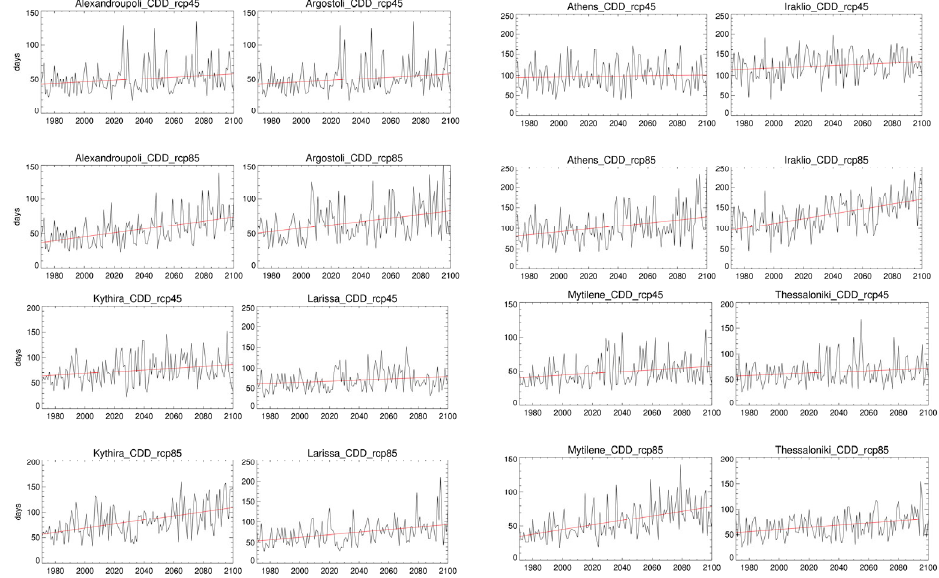
Figure 8. Consecutive dry days (CDD) during 1971–2100 in eight Greek stations based on RCP4.5 (first and third rows) and RCP8.5 (second and fourth rows).